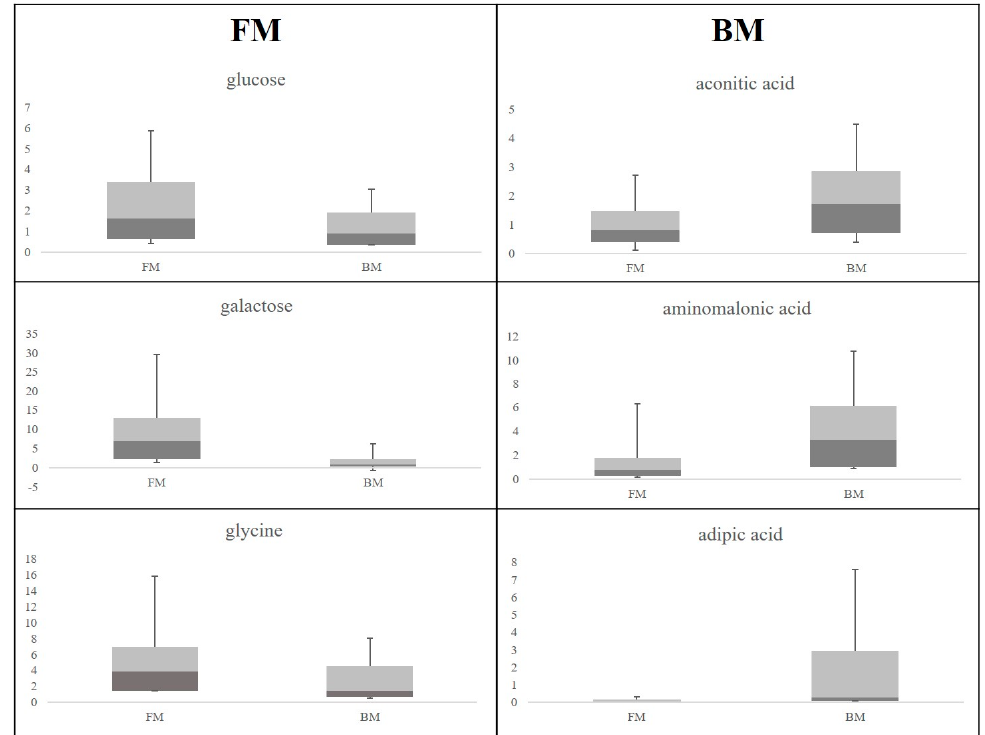
Figure 4. Comparison between the most discriminant metabolites. Box plots display the metabolite quantitative variation in each class.